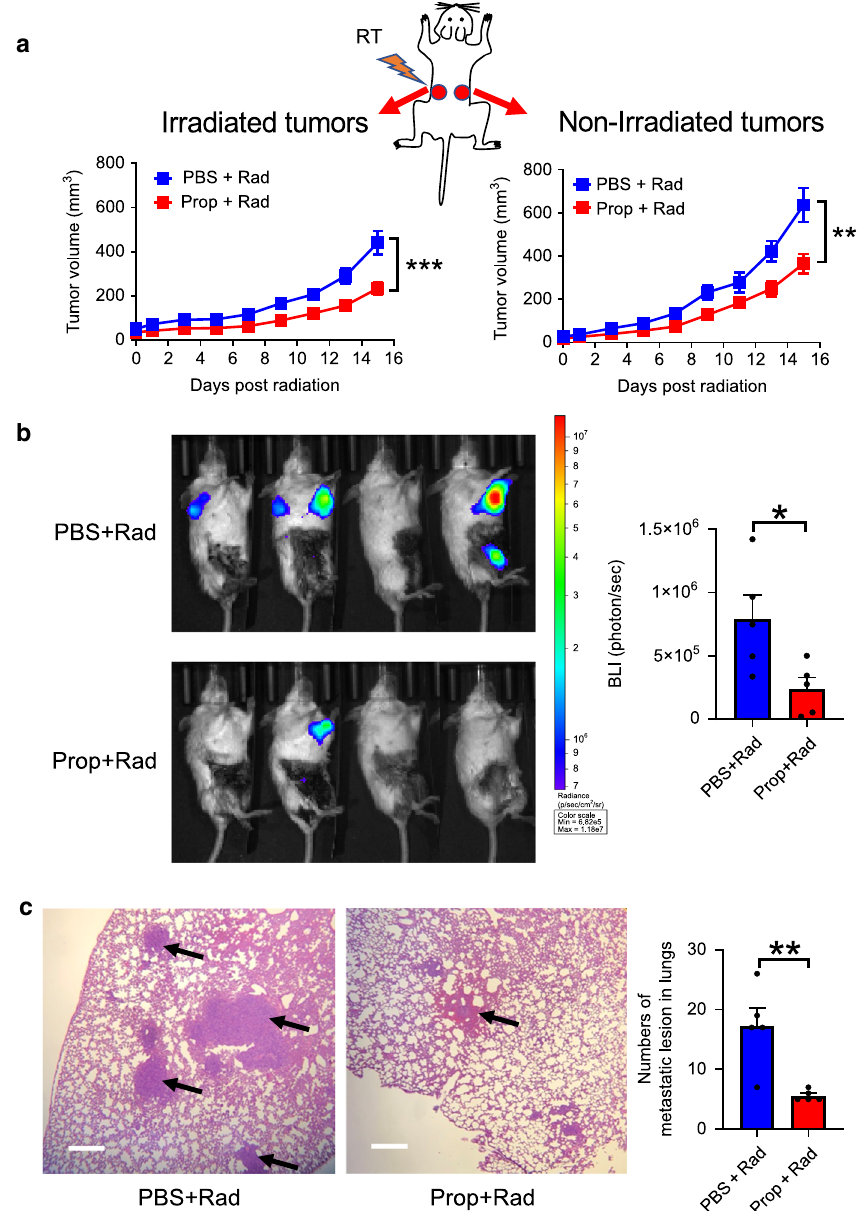
Fig. 5 Blockade of β -adrenergic signaling reduces spontaneous metastases in the 4T1-luc breast carcinoma model. a Tumor growth of irradiated tumors (left) and non-irradiated tumors (right) is shown. Data are presented as mean ± SEM. ** P < 0.01; *** P < 0.001 (two-way ANOVA analysis). n = 12 biologically independent mice in PBS + Rad group and n = 18 biologically independent mice in Prop + Rad group. On Day 33 post tumor implantation, bioluminescent images of luciferase activity b were acquired and histologic analysis of lung tissues was shown in c . Staining with eosin hematoxylin was performed (×40 magni fi cation, scale bars = 500 µ m) and black arrows showed metastatic lesions. Data are presented as mean ± SEM. * P < 0.05; ** P < 0.01 (Student ’ s t test analysis). For b and c , n = 5 biologically independent mice in all